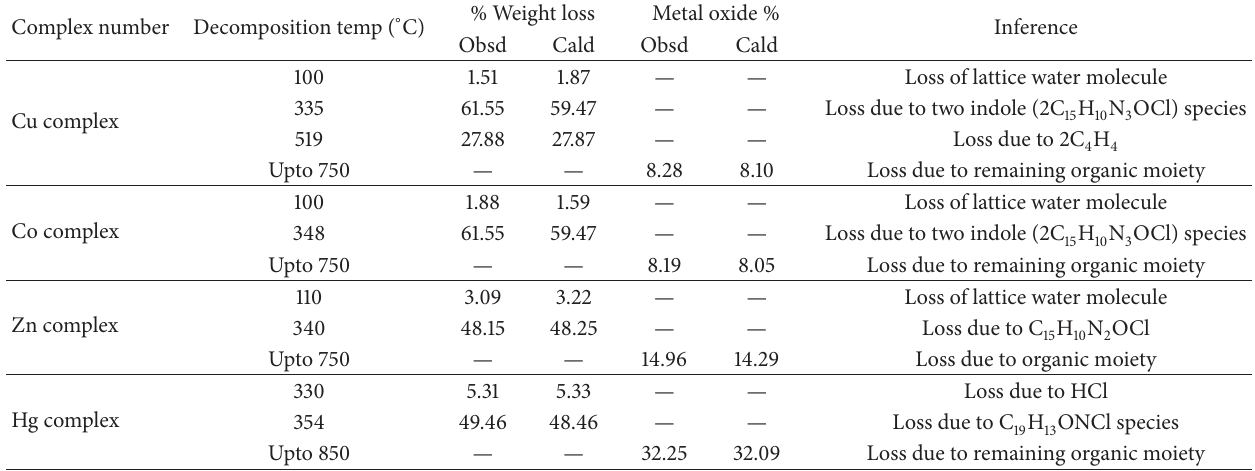
Table 5: Thermal decomposition of the complexes.